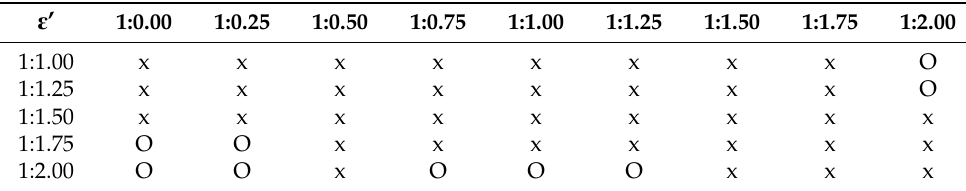
Table A6. Significant difference in dielectric constant between various Slacker concentrated groups. A significant difference was indicated with O and an insignificant difference was indicated with x. Table A6. Cont.